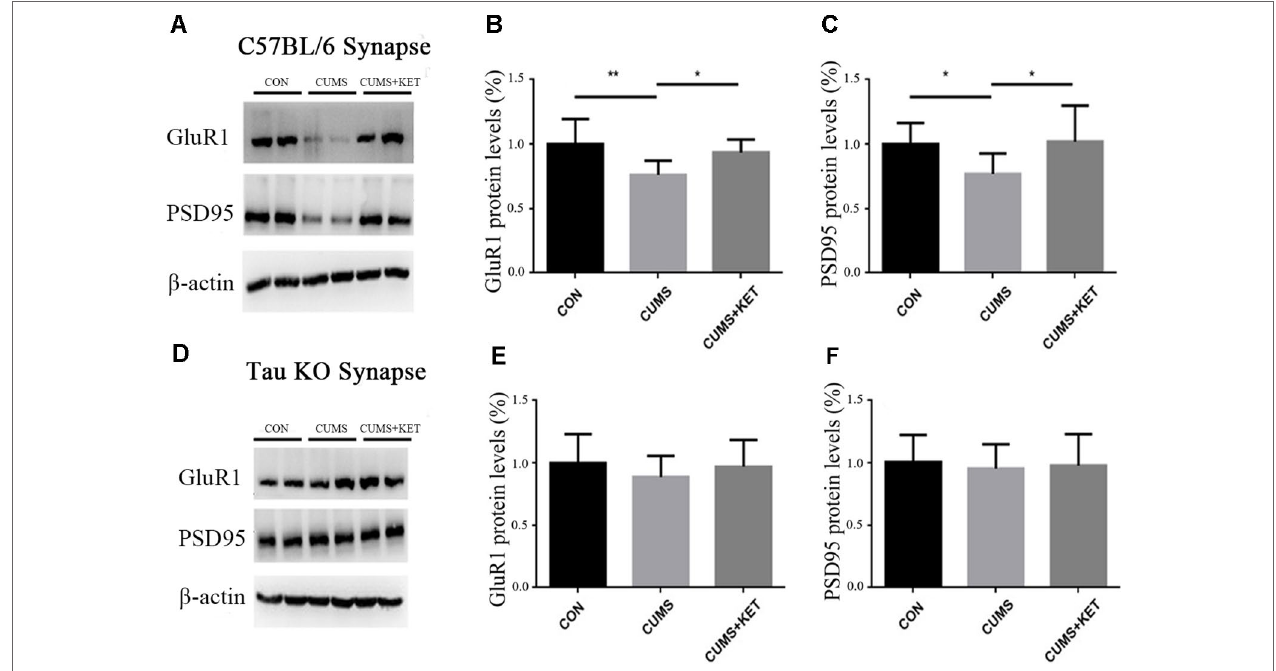
FIGURE 6 | CUMS decreased the levels GluA1 and PSD95 of hippocampus synapses in C57BL/6 mice, with a rapid reversal by ketamine. CUMS did not decrease the levels of GluA1 and PSD95 of hippocampus synapses of Tau KO mice, and ketamine had no effect on the Tau KO mice. (A) Representative Western blot images of the GluA1 and PSD95 of C57BL/6 mice are shown. (B and C) CUMS decreased the expression of GluA1 and PSD95, and this deficit was reversed by a single dose of ketamine. (D) Representative Western blot images of GluA1 and PSD95 of Tau KO mice are shown. (E and F) CUMS and ketamine did not change the levels of GluA1 and PSD95 of Tau KO mice. Results were quantified and expressed as the mean ± SD percent of the control; n = 10 (* p < 0.05, ** p <